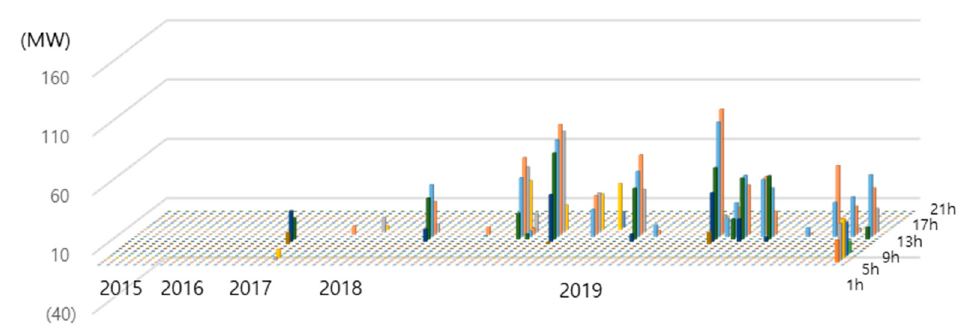
Figure 9. Renewable energy curtailment with an ESS.